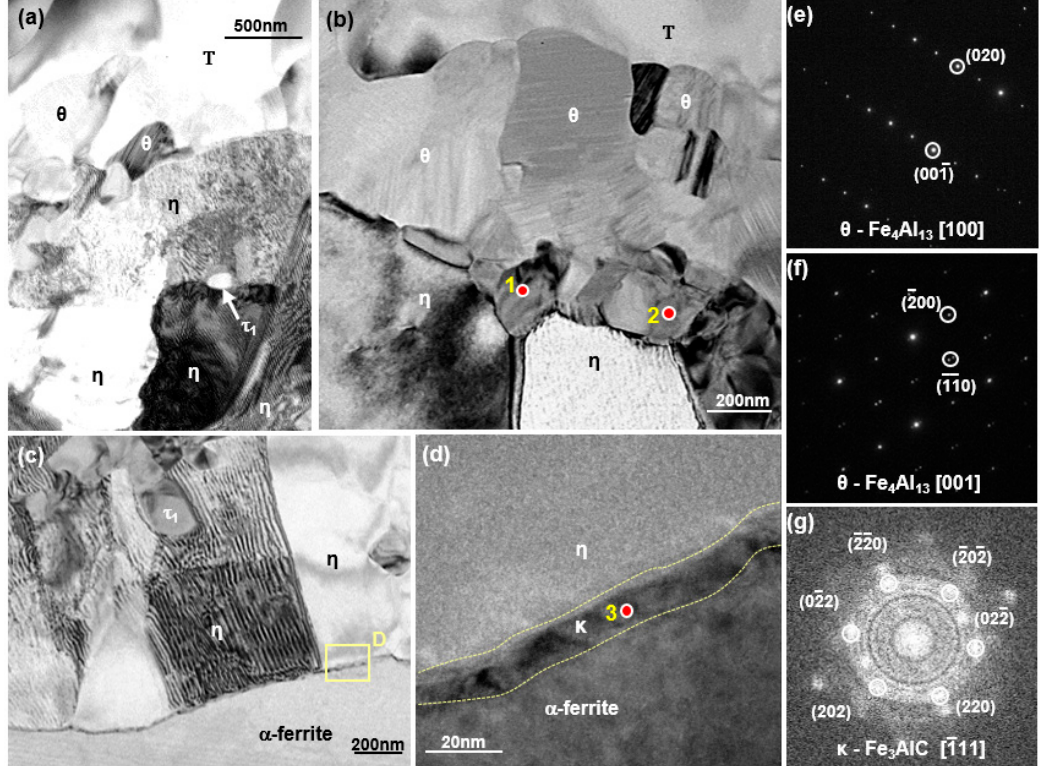
Figure 9. Bright-field images observed from rectangular area denoted as X-Z in Figure 6: ( a ) X area, ( b ) Y area, ( c ) Z area, and ( d ) HR-TEM image observed from rectangular area denoted as D in ( c ) and diffraction patterns and key diagram ( e – g ) denoted as 1–3 in ( b ) and ( d ).